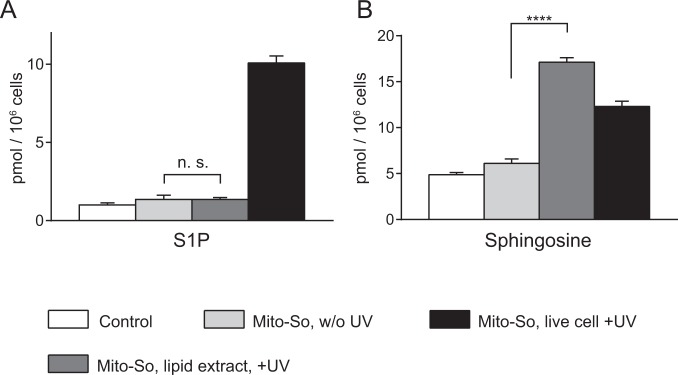
Mito-So was not phosphorylated in Hela cells in its caged form.Cells were incubated with DMSO or caged probes (2 μM) for 15 min. From left to right, cells were collected only for lipid extraction (control; Mito-So, w/o UV); or cells were collected for extraction, dried, re-suspended in 200 water and irradiated for 10 min on ice (Mito-So, lipid extract,+UV); or cells were irradiated for 2 min on ice before lipid extraction (Mito-So, live-cell +UV). Extracted lipids were derivatized by AQC, and measured by LC-MS/MS. Values were normalized with respect to the amount of C17 internal standards and cell numbers. Data represents the average of three independent experiments. Error bars represent SEM. ****p<0.0001, n.s., not significant, student's t-test.